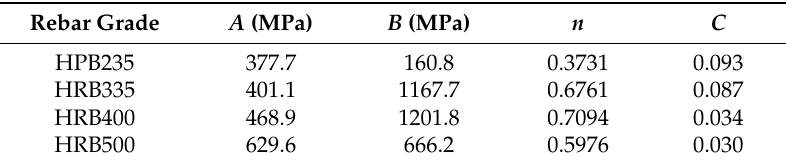
Table 3. Parameter values in the Johnson–Cook